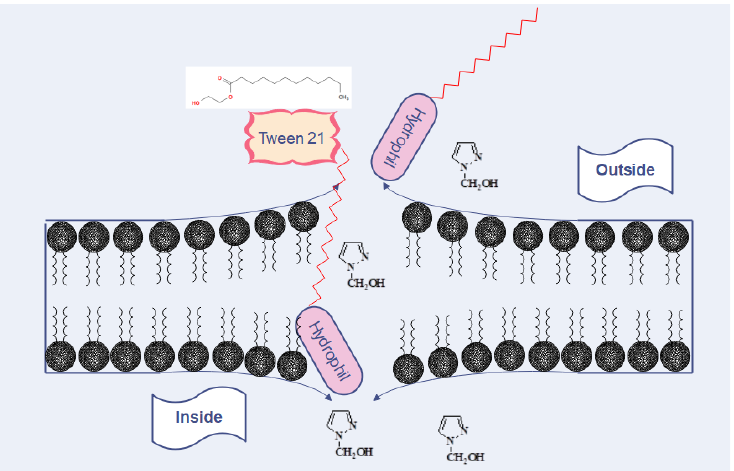
Figure 10. The potential mechanism of the action of T21 affects the influx of pyrazoles to the inside of bacterial cells. T21 interacts and destabilizes the double layer of phospholipids with the creation of “pores”, through which the improved transfer of pyrazoles takes place. In this way, the accumulation of pyrazole leads to the increase in the intracellular concentration and the killing of bacterial cells, a fact that could explain the decrease in the MIC and the improvement of the antimicrobial effect of pyrazoles when combined with T21.